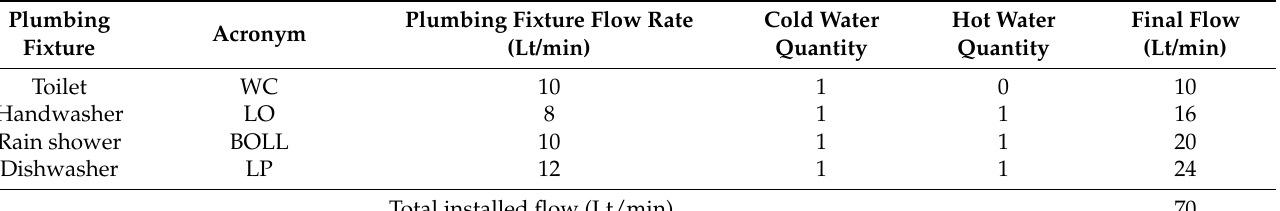
Table 14. Flow rate table for type 1 retail store.